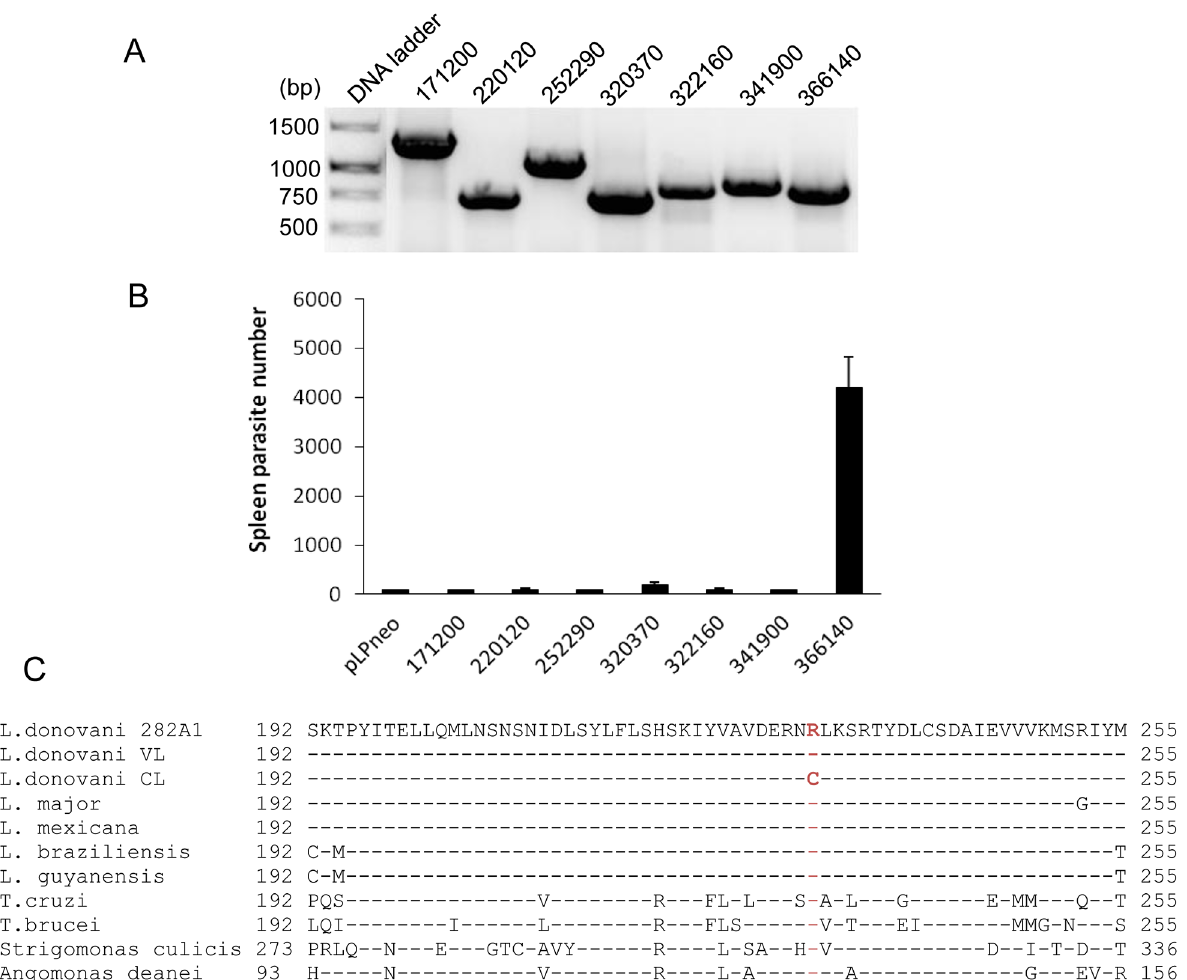
Figure 2. Expression of VL-SL RagC gene (366149) in the CL-SL isolate increased its survival in the spleen. Genes from the VL-SL isolate were expressed in the CL-SL isolate, and spleen infection levels assessed in mice following intravenous infection. The VL-SL genes included are: LdBPK171200.1, steroid dehydrogenase; LdBPK220120, phosphoinositide phosphatase; LdBPK252290, DnaJ protein; LdBPK320370, hypothetical protein; LdBPK322160, rab-2a; LdBPK341900, NAD dependent deacetylase; LdBPK366149, Rag C (ras like GTPase C). Panel A. RT-PCR shows that all the corresponding VL-SL genes were transcribed in the transfected CL-SL L. donovani cells. Panel B. Infection levels in the spleen 4 weeks after infection. Values are mean plus standard error. Panel C. Alignments show that amino acid R231 in Rag C proteins is highly conserved in Leishmania and Trypanosomes .